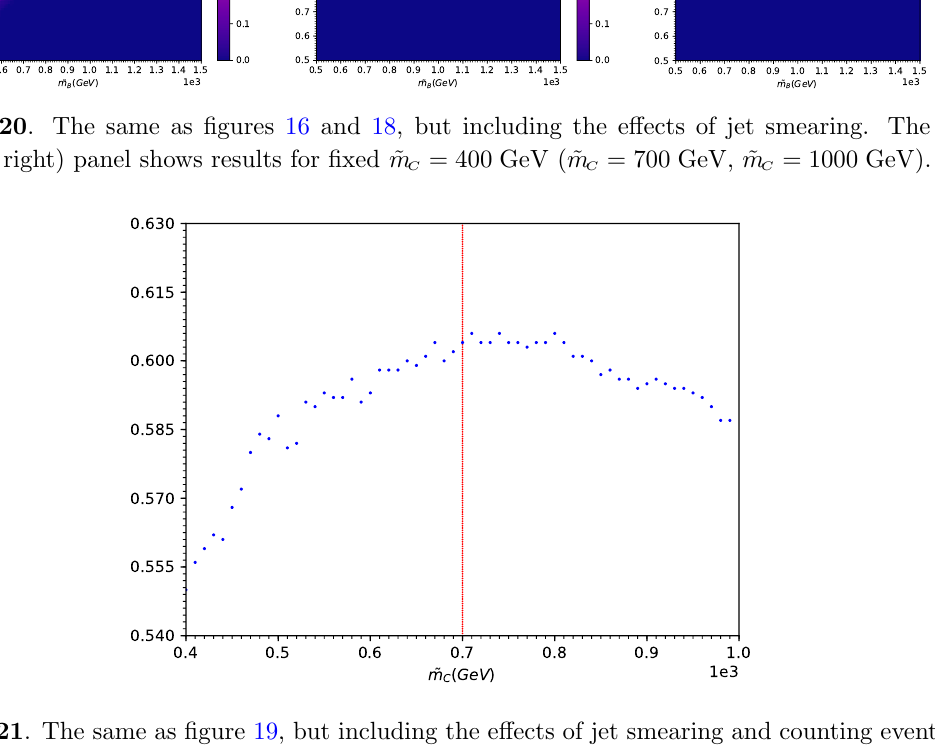
Figure 21 . The same as (cid:12)gure 19, but including the e(cid:11)ects of jet smearing and counting events in a larger (30 (cid:2) 30 GeV) collection